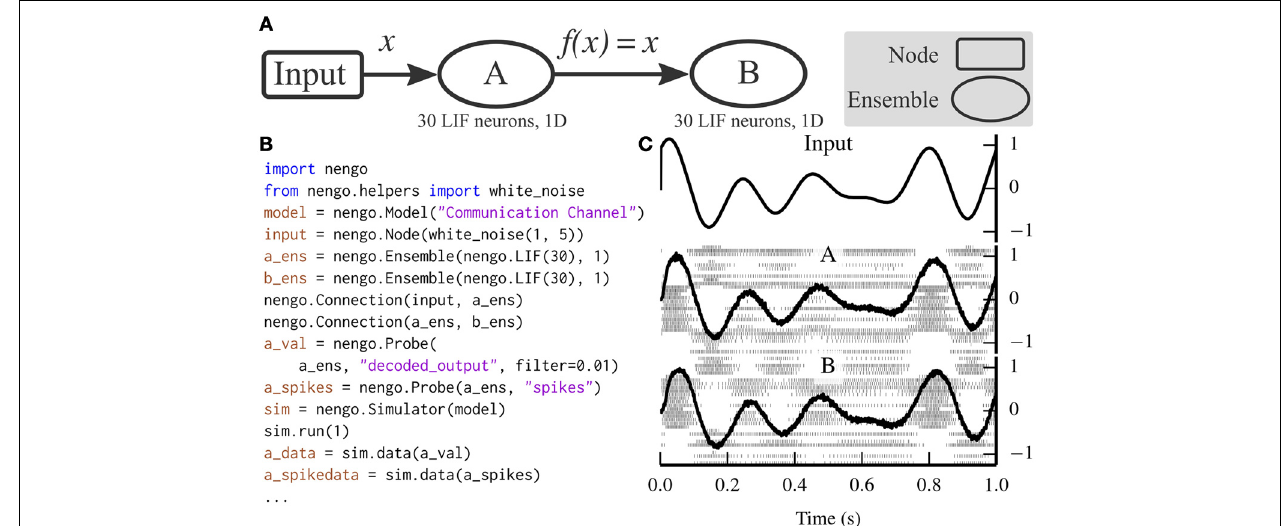
FIGURE 3 | A communication channel implemented with Nengo. (A) Diagram depicting the model. Ensemble A projects its encoded signal to ensemble B unchanged. (B) Nengo code to build and simulate the model for 1s. (C) The results of the simulation. The input signal (top